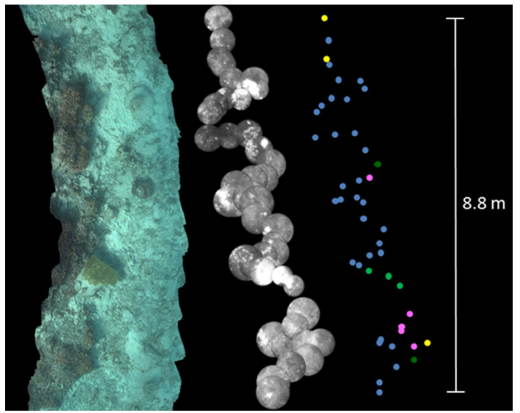
Figure 7. Comparison of the seabed mosaic of video images ( Left ), the seabed mosaic of fluorescence LIDAR images ( Center ), and the data analyst’s eye judgement classification of substrates ( Right : ‚ blue circles: branch—type coral, ‚ green circles: table—type coral, ‚ dark green circles: coral observed at low-resolution, ‚ yellow circles: juvenile coral or coral piece, ‚ pink circles: dead coral rubble).